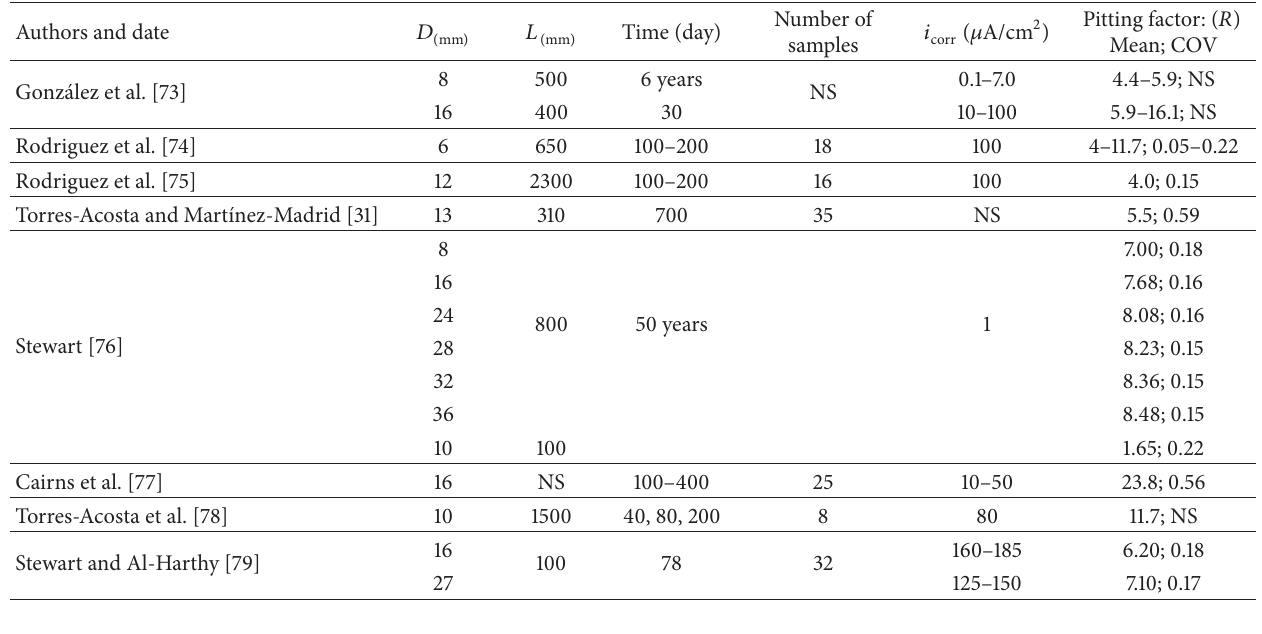
Table 3: Pitting factors obtained from literature.